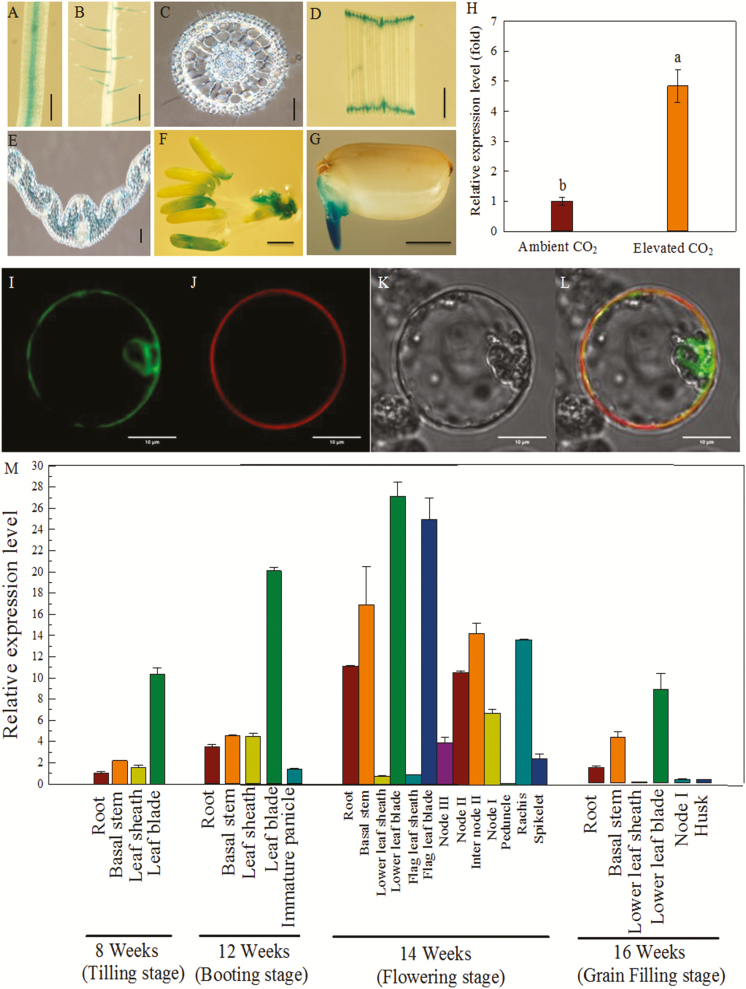

OsPIP1;2 expression pattern and subcellular localization. (A–G) Rice transformed with OsPIP1;2 promoter::GUS. GUS activity in the root (A), lateral root elongation zone (B), cross-section of the root tip (C), leaf blade (D), cross-section of the leaf blade (E), floret (F), and germinating seeds (G). Scale bars: 100 μm (C, E) and 1 mm (A, B, D, F, G). (H) Response of OsPIP1;2 expression to CO2 in leaf blade by quantitative real-time PCR. The internal reference gene was OsActin. Values are means ±SD (n=3); different letters indicate significant differences (P<0.05). (I–L) Subcellular localization of OsPIP1;2 in rice protoplasts. Scale bars: 10 μm. (I) Fluorescence signal of 35S::OsPIP1;2-GFP. (J) fluorescence signal of OsMCA1 (Takamitsu et al., 2012). (K) bright-field image. (L) merged image. (M) Expression levels of OsPIP1;2 in the indicated tissues and at the indicated growth stages of the wild type (WT) (cv. Nipponbare) grown in soil, as determined by quantitative real-time PCR with OsActin as an internal reference. Values are means ±SD (n=3).